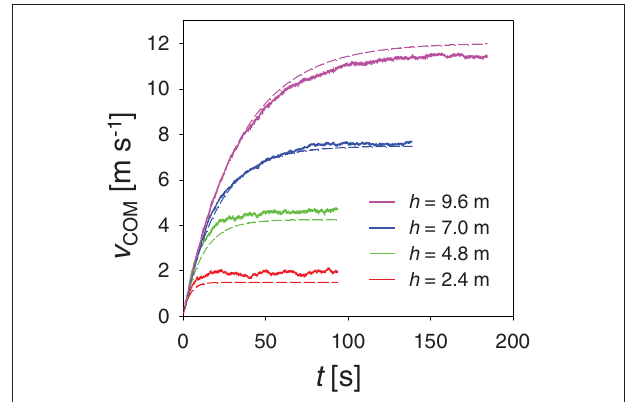
FIGURE 3 | Center of mass velocity during acceleration down a slope for landslides of thickness h = 2.4 − 9.6 m. Simulation results (solid lines) are compared to analytical prediction (dashed lines) after Equation (11). Note that larger landslides reach larger steady flow velocity. However, it takes them correspondingly longer